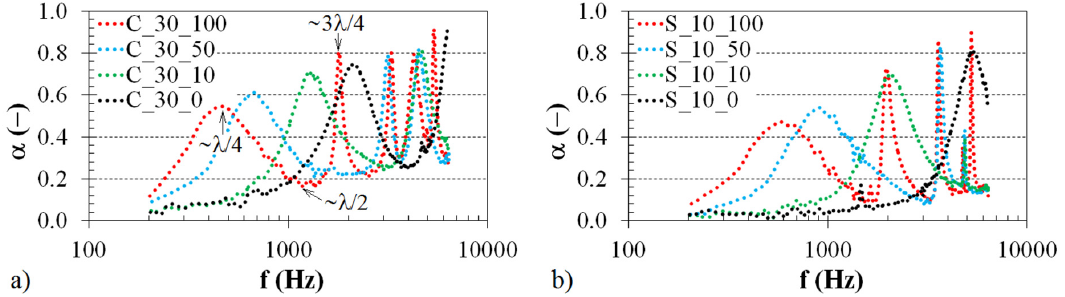
Figure 6. Effect of the air gap size on the frequency dependencies of the sound absorption coefficient for the investigated ABS samples with a ( a ) Cartesian and ( b ) Starlit structure.